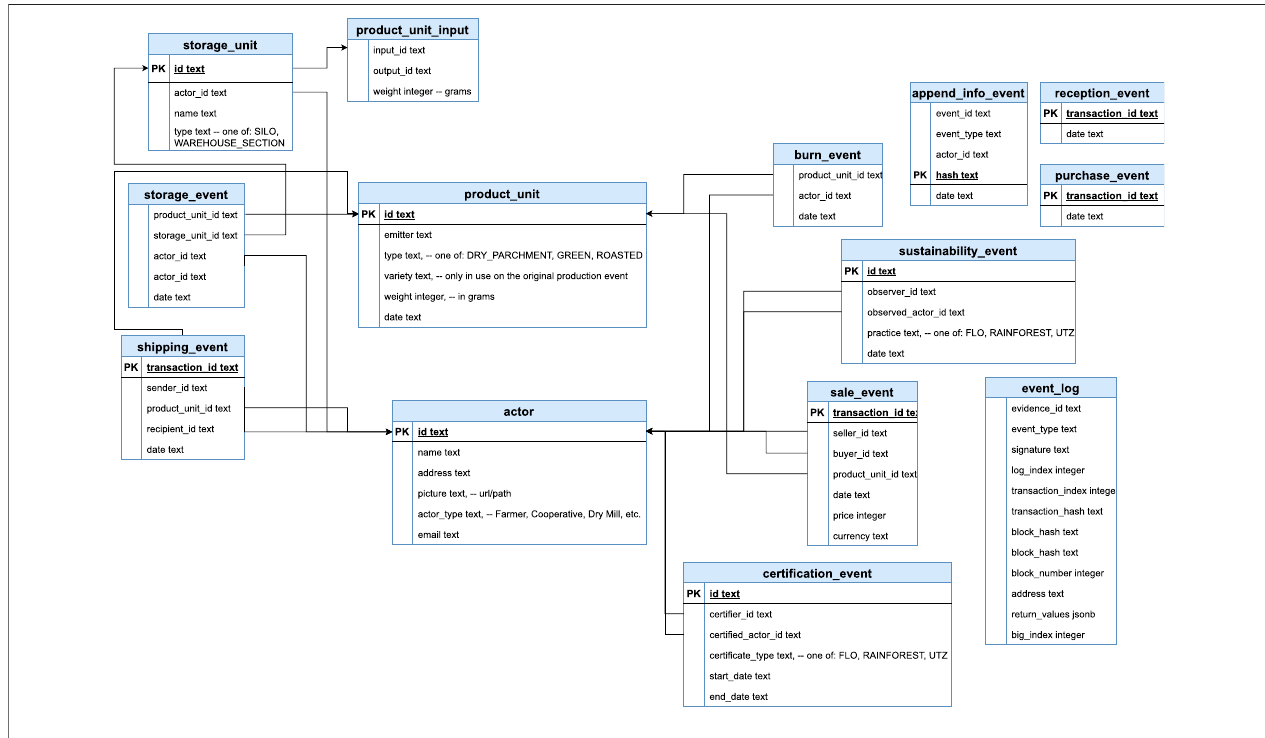
FIGURE 3 | ER-Diagram of the core data